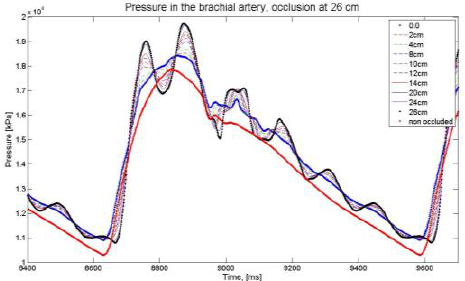
FIGURE 3: Pressure waveforms at several points in the brachial